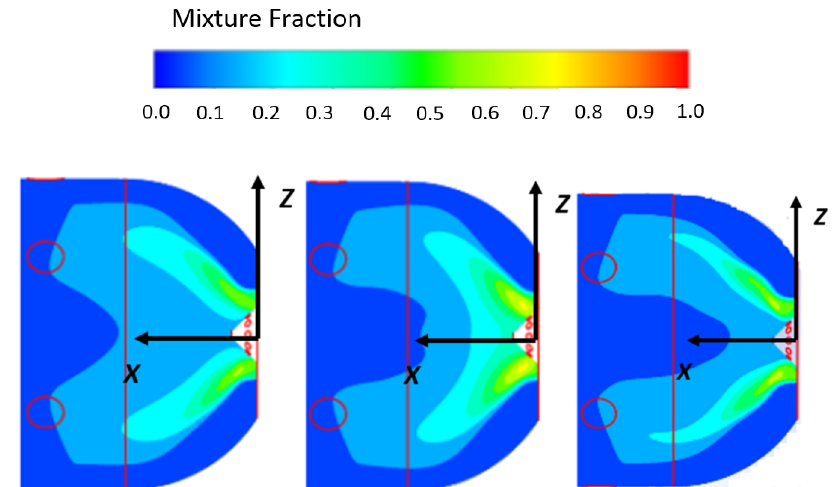
Figure 3. Time-averaged mixture fraction distribution in the main flame region of the combustor ( y = 0 mm). Left: SSTKW, Middle: RSM, Right: SSTKWSAS.